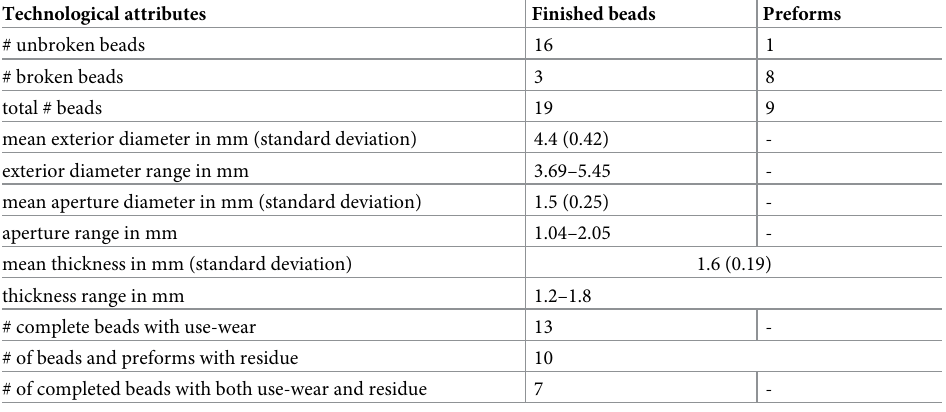
Table 2. Technological features for the OES beads and preforms from the MIS 2 deposit at Ga-Mohana Hill North Rockshelter. Complete beads are those identified as stage VI and VII following Orton [54]. Standard deviations are included in brackets where